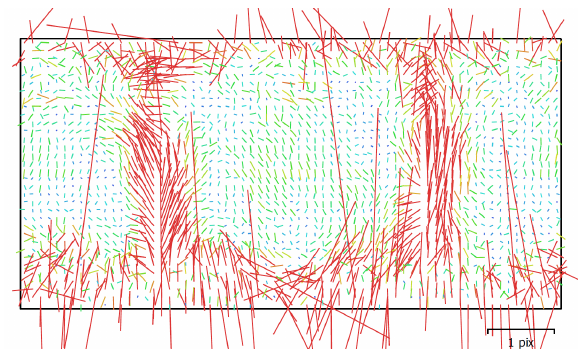
Figure 18 . Visualization of image residuals after image